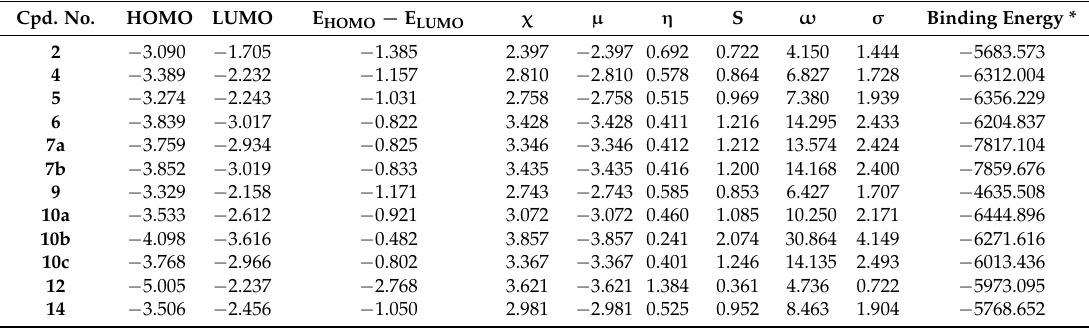
Table 1. Calculated global reactivity descriptors for the antipyrinyl-thiazole derivatives. Cpd.